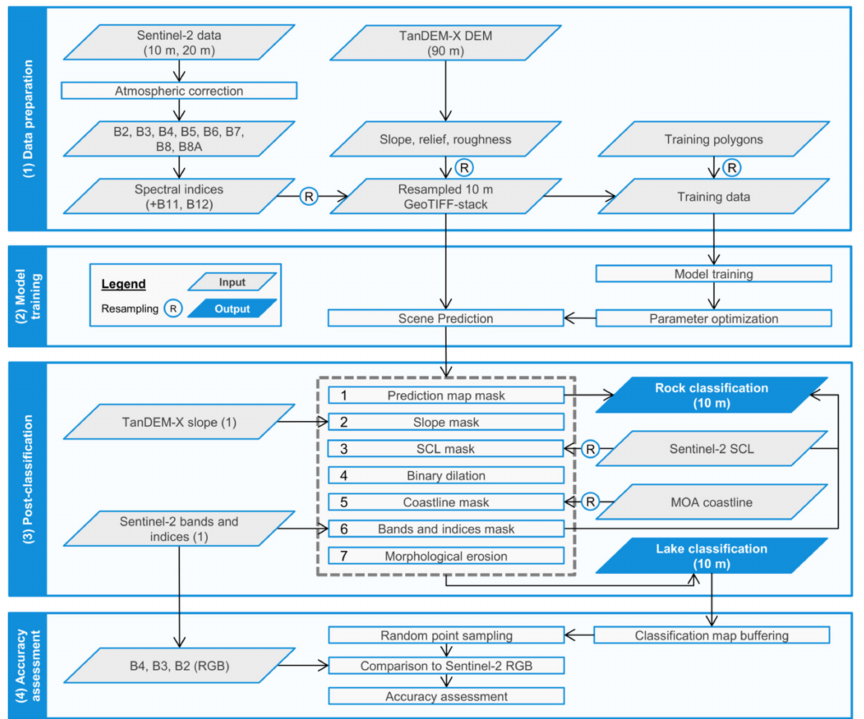
Figure 2. Workflow for automated supraglacial lake mapping in